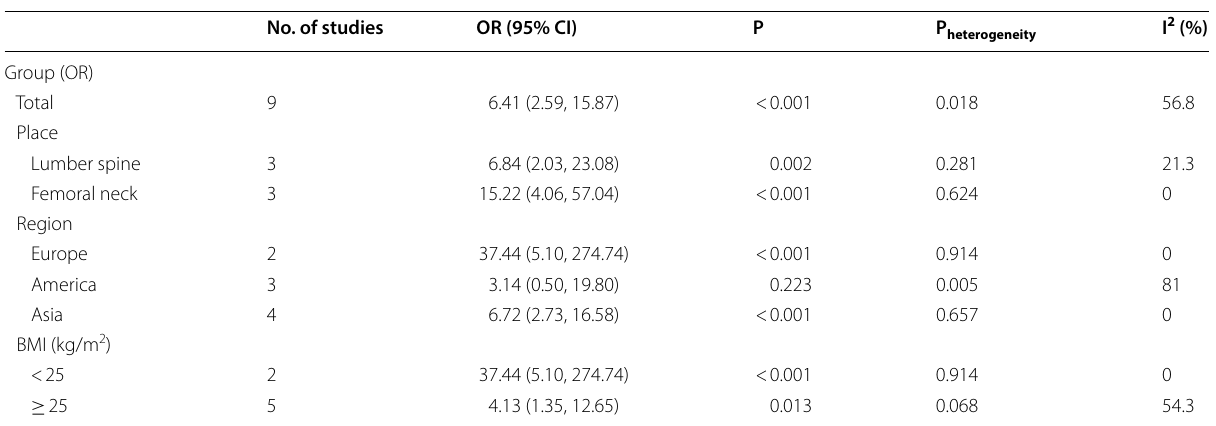
Table 2 Subgroup analysis of